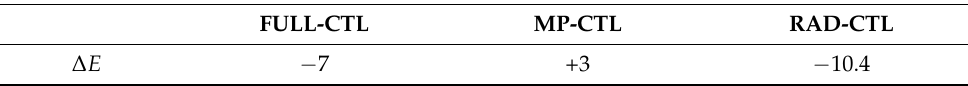
Table 11. Area average of mean surface energy budget [Equation (6)]. Units are W m − 2 . FULL-CTL